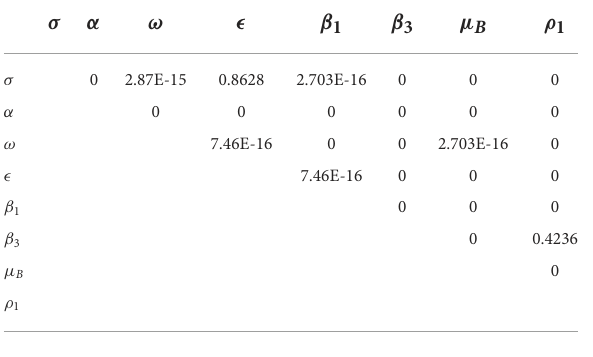
TABLE 5 Pairwise PRCC comparisons (FDR adjusted P -values).